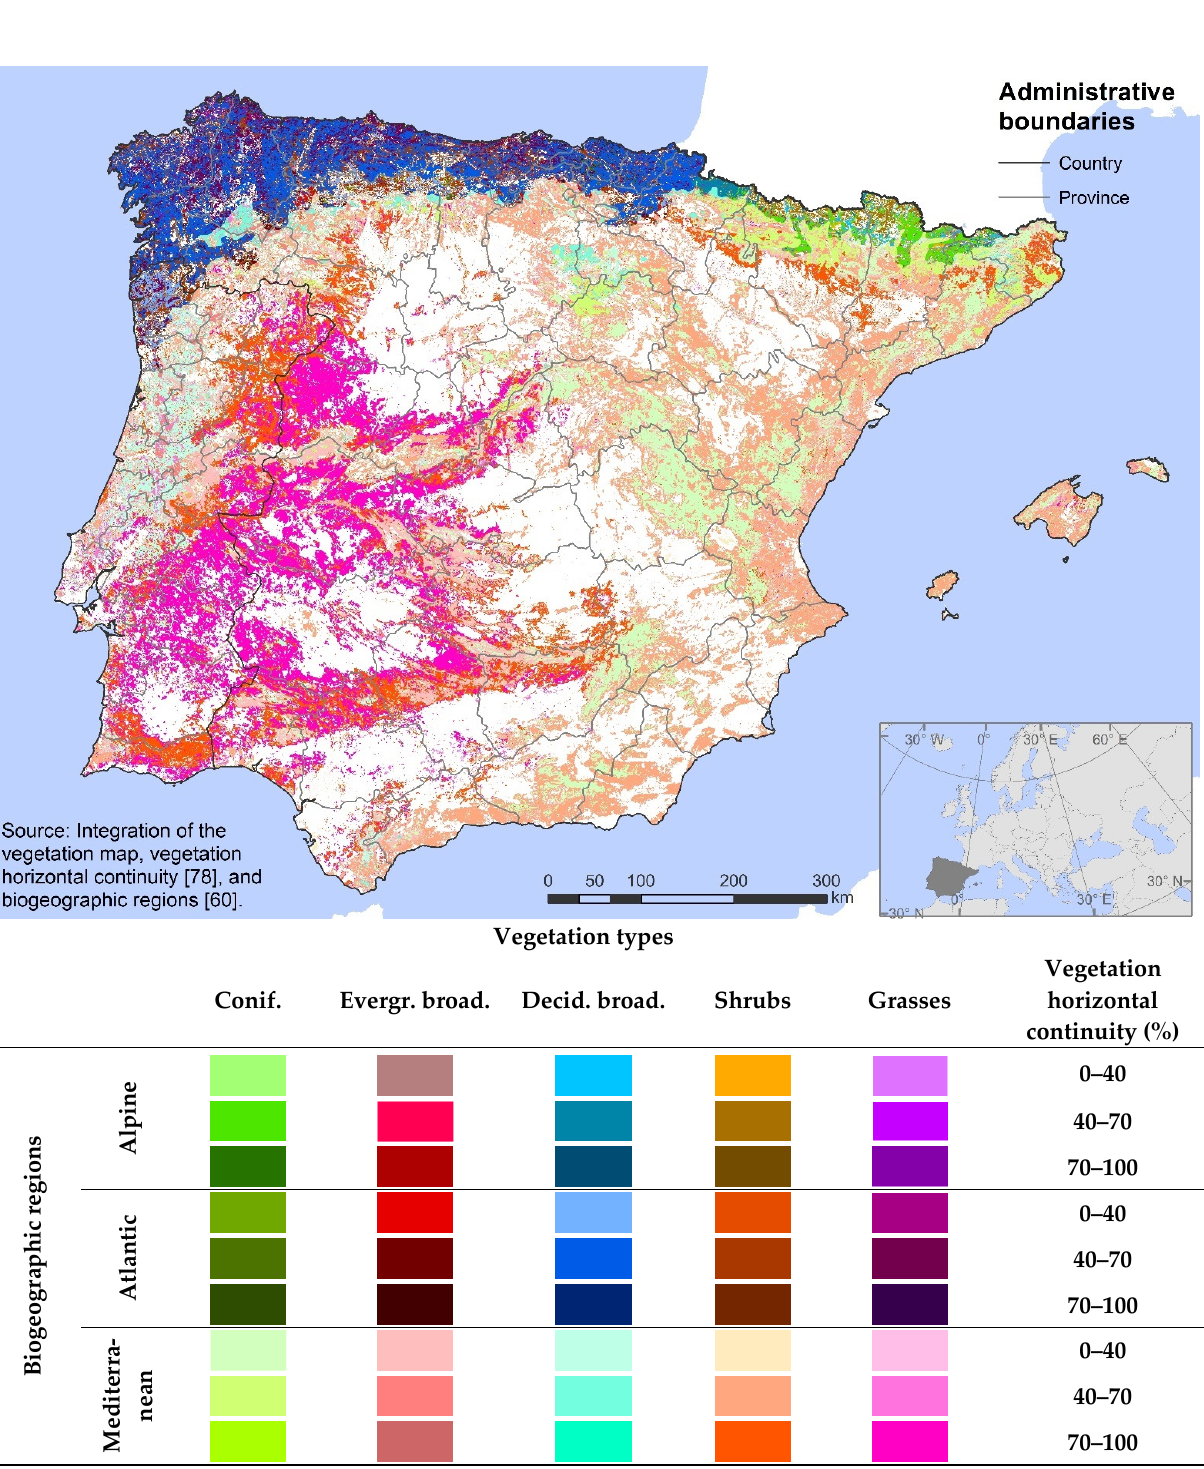
Figure 6. Iberian fuel map for the Iberian Peninsula and the Balearic Islands (2020–2021). The colours are based on the global fuel map of [54].